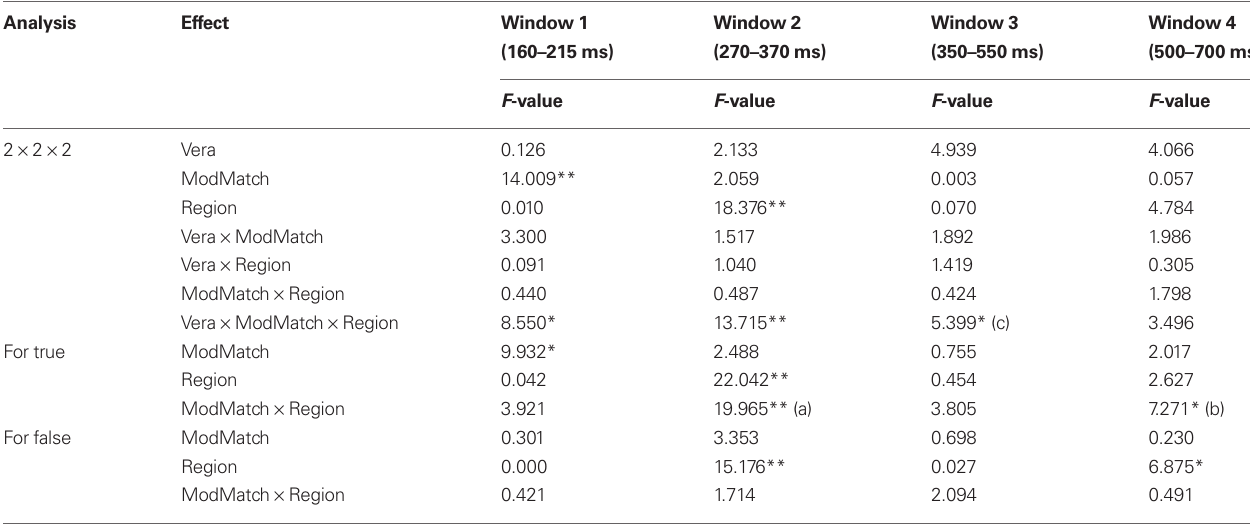
Table 2 | Results of the Veracity × ModMatch × Region analysis for each window, with follow-up analyses for the results of ModMatch × Region within levels of Veracity